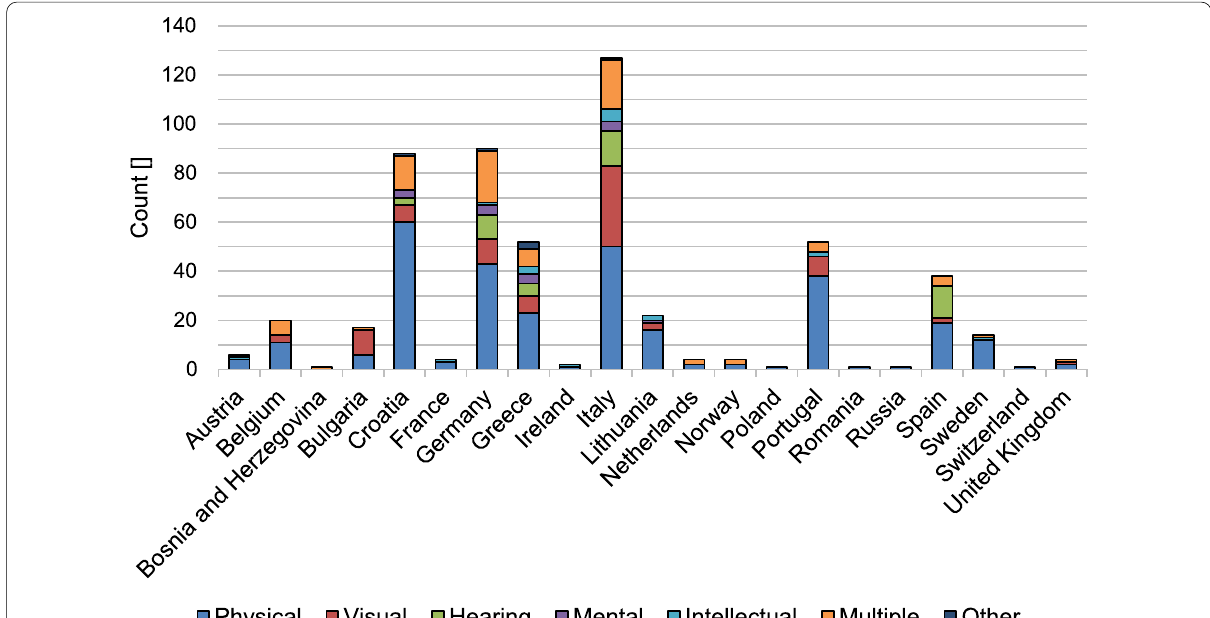
Fig. 1 Completed surveys per country of residence split by type of disability ( n and therefore discarded for n 2 surveys each; respondents whose disabilities did not fit into any of the pre-defined categories were assigned to = the category